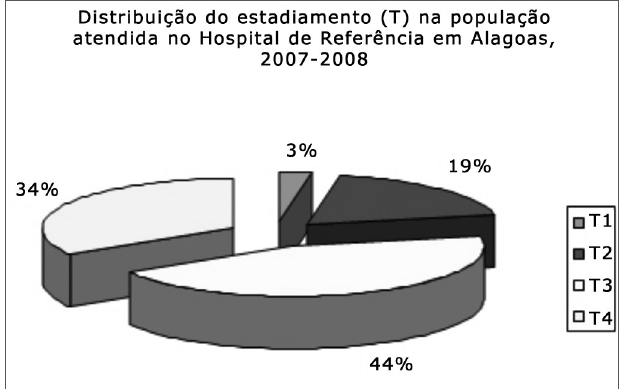
Figura 2. Distribuição do estadiamento detectado. Tabela 2. Frequência de respostas à questão aberta: Por que não procurou o serviço de saúde